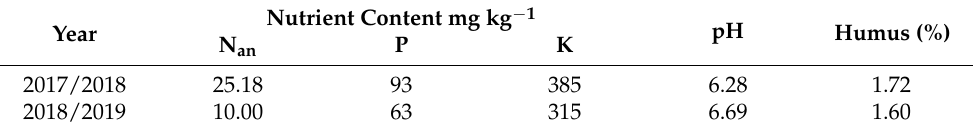
Table 2. Nutrients and humus contents, soil pH in soil after analysis in autumn and spring, respectively.